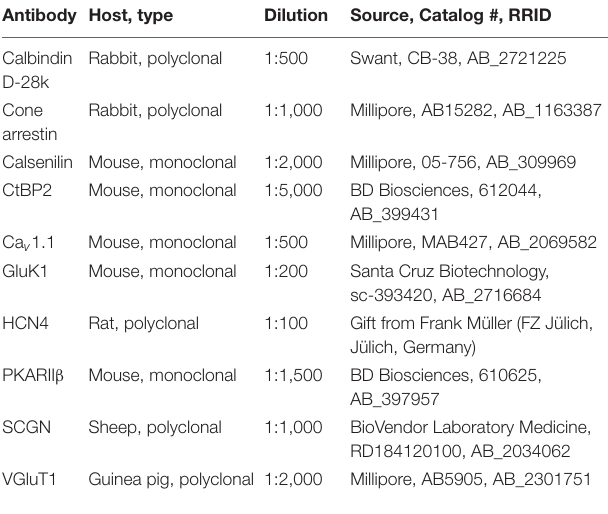
TABLE 1 | List of primary antibodies used in this study.